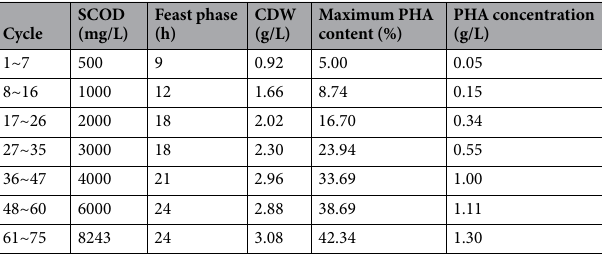
Table 2. The primary parameters for the whole process of enriching PHA-producing MMC fed by valerate-dominant sludge hydrolysate with increasing initial concentrations. The results of ‘feast phase’, ‘CDW’, ‘maximum PHA content’ and ‘PHA concentration’ are the average of the last three batches for each concentration. ‘CDW’ and ‘PHA concentration’ indicate the values at the end of feast